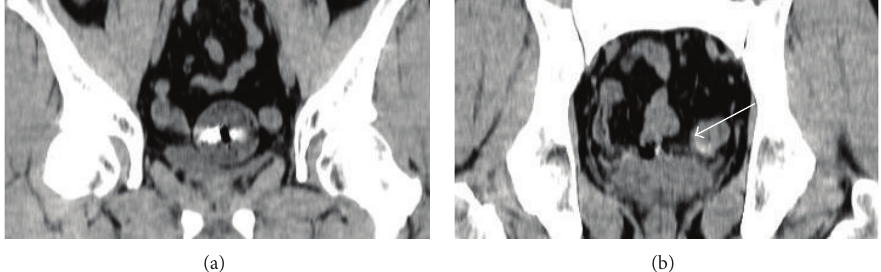
Figure 2: Coronal view by CT showed CE capsule retention in the small intestinal lumen with dilatation and fluid collection (a), and the finding was suspicious for stenosis ((b), arrow).